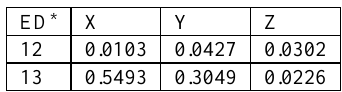
Table 1. RMSE values RTS change measurement in X,Y,Z coordinates during three